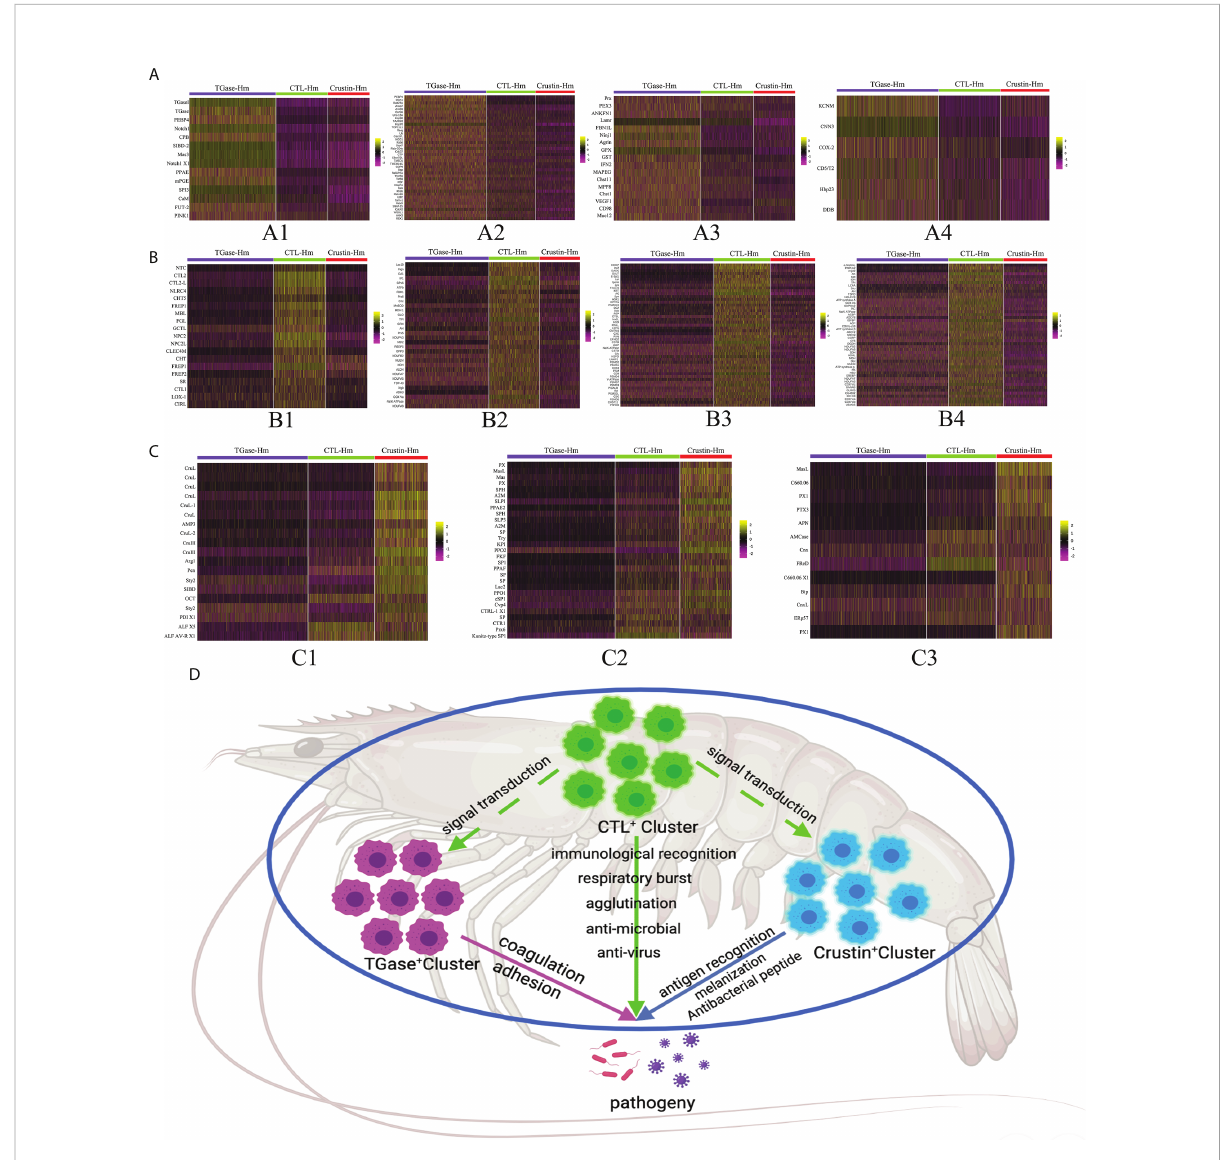
FIGURE 3 ScRNA-seq unveils the functional characteristics of different hemocyte clusters. (A – C) The heatmaps shows the expression pro fi les of the different functional feature genes in Cluster 0, Cluster 1 and Cluster 2 (TGase + cluster, CTL + cluster and Crustin + cluster), respectively. Color gradient represents the expression level of each single cell (Supplementary File 5). (D) The schematic exhibits the functional characteristics and interactions of the three hemocyte